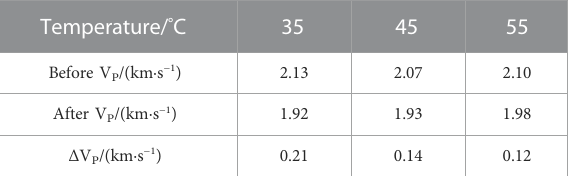
TABLE 6 Comparison of P-wave velocity V P before and after being subjected to supercritical CO 2